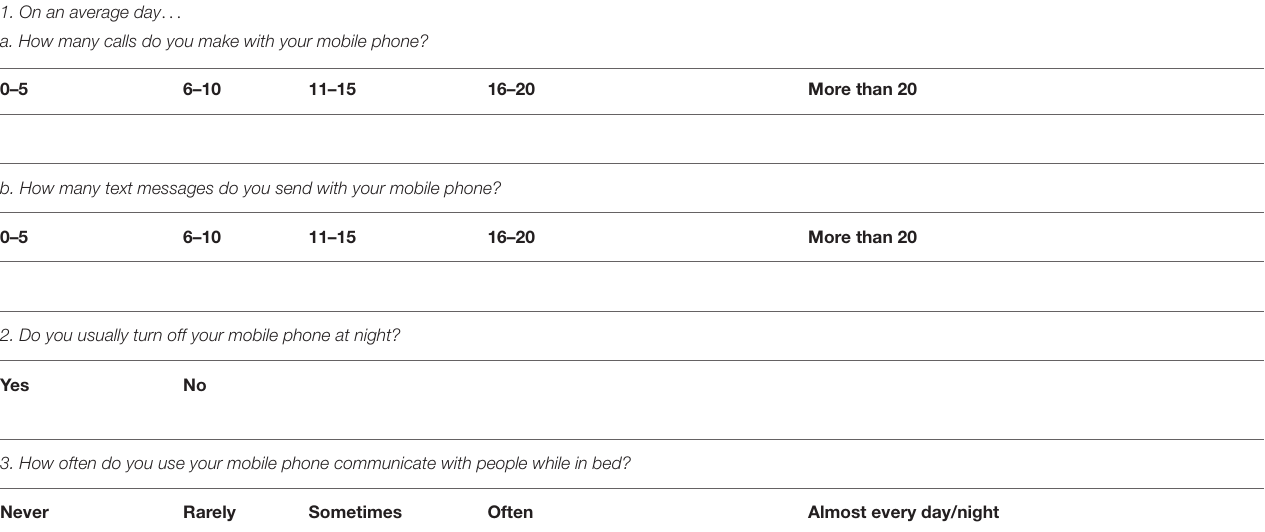
TABLE 1 | The questionnaire (Translated from the Spanish version of the TMD, for purpose of the reader). 1. On an average day